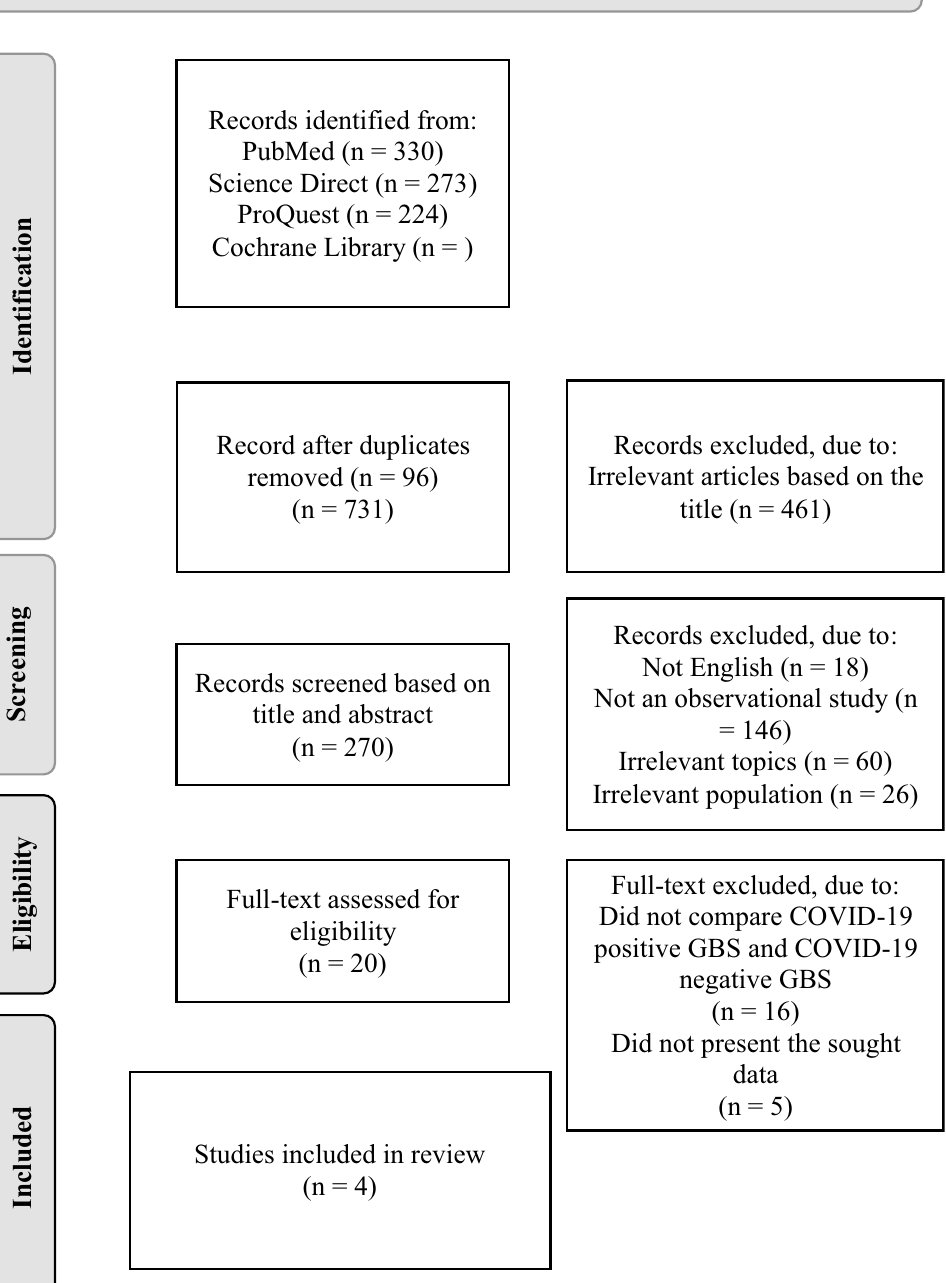
Fig. 1 Article selection flow based on PRISMA